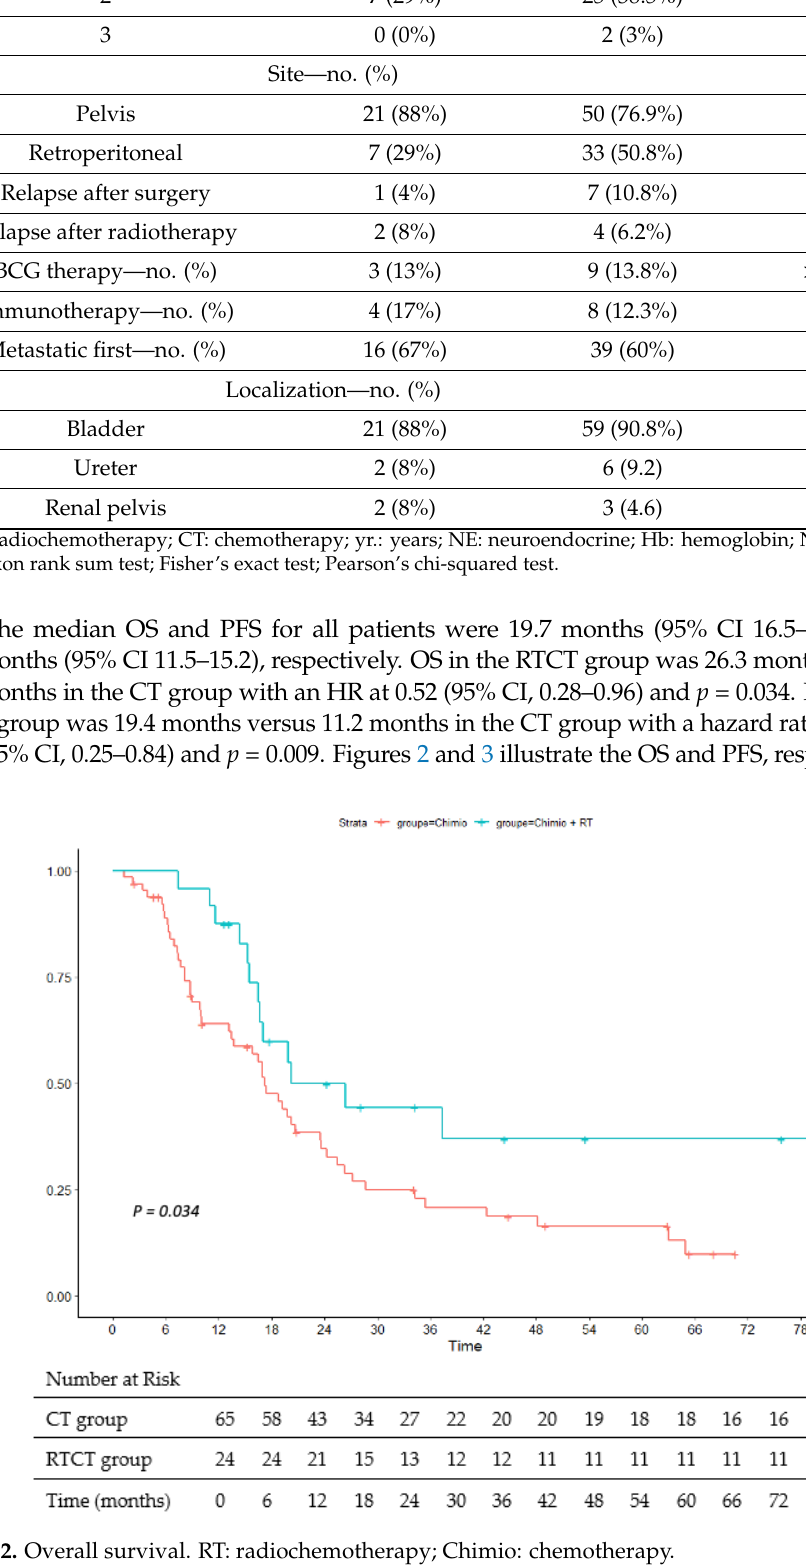
Figure 2. Overall survival. RT: radiochemotherapy; Chimio: chemotherapy.